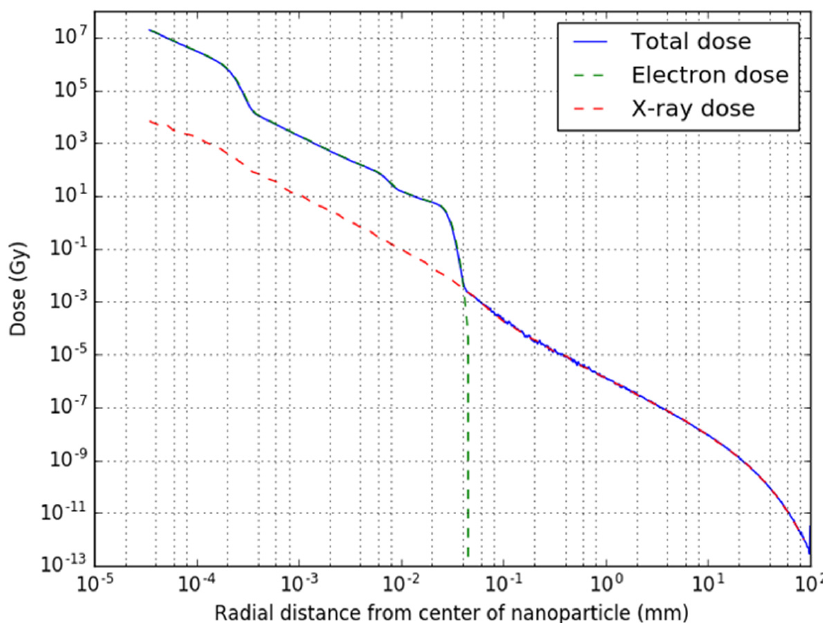
Figure 6. Radial dose profile of the combined radiation of one nanoparticle with 5 nm palladium core and 20 nm iron oxide shell after 100,000 decays.